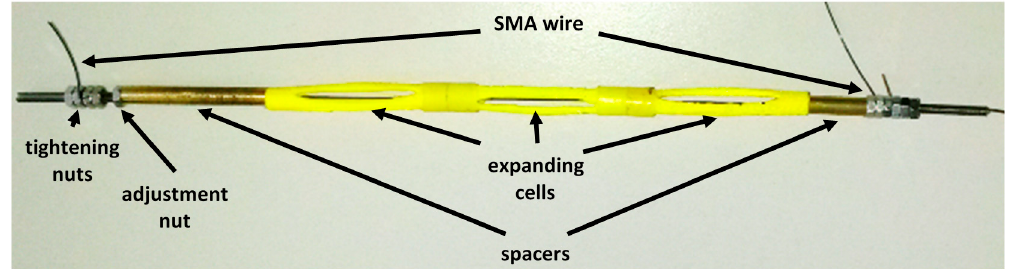
Figure 17. Three cells prototype, integrated with the SMA wire [30]. Actuators 2018 , 7 , x